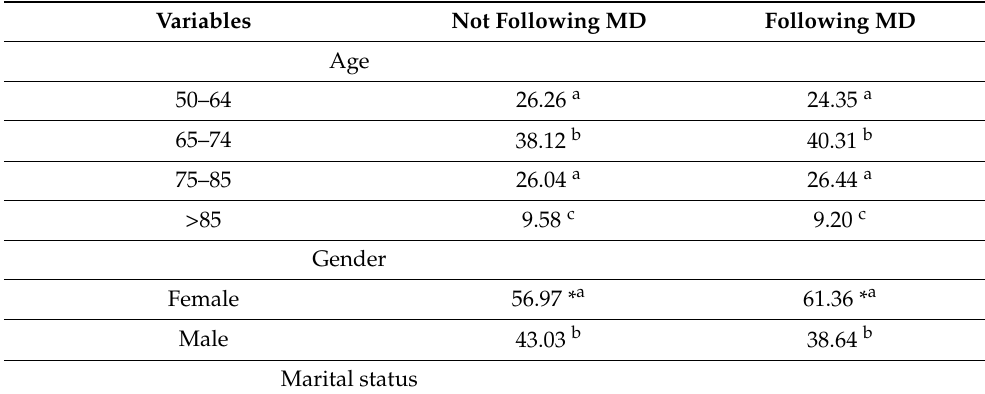
Table 1. Characteristics of the population due to following or not following the Mediterranean diet.